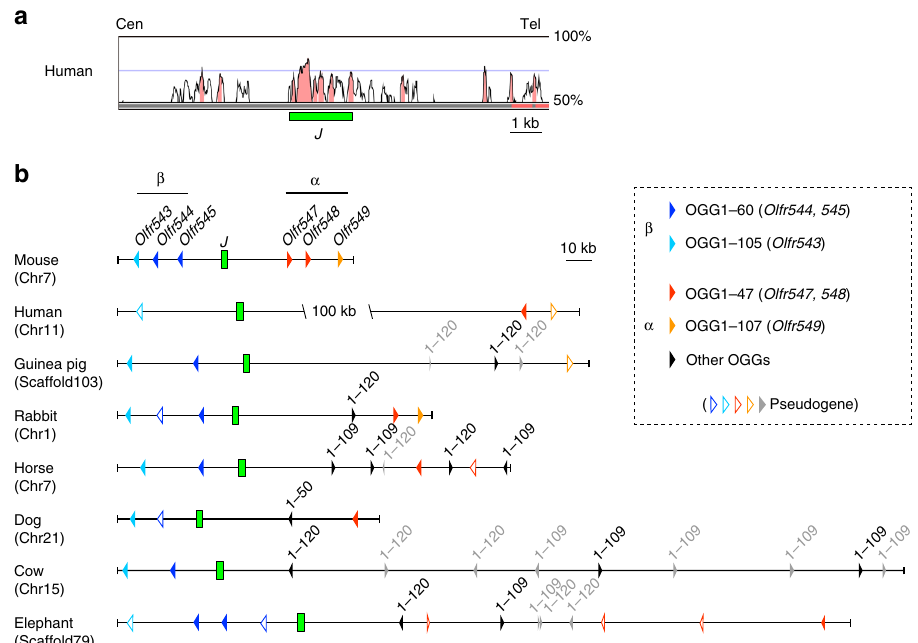
Fig. 2 The J element is the most highly conserved element among OR enhancers. a Nucleotide percent identity plot (VISTA plot) of the junctional region of α - and β -class I OR genes in mouse and human. A 1.9-kb intergenic region, named the J element, was identi fi ed as a highly conserved region. b Genomic organization of α -, β -class I OR genes and of the J element in placental mammalian species as a representative of each order. Class I OR genes belonging to different OGGs are depicted by arrowheads of different colors (intact genes, fi lled ; pseudogenes, outlined ) 5 . The transcriptional orientation of each OR gene is indicated by the orientation of its